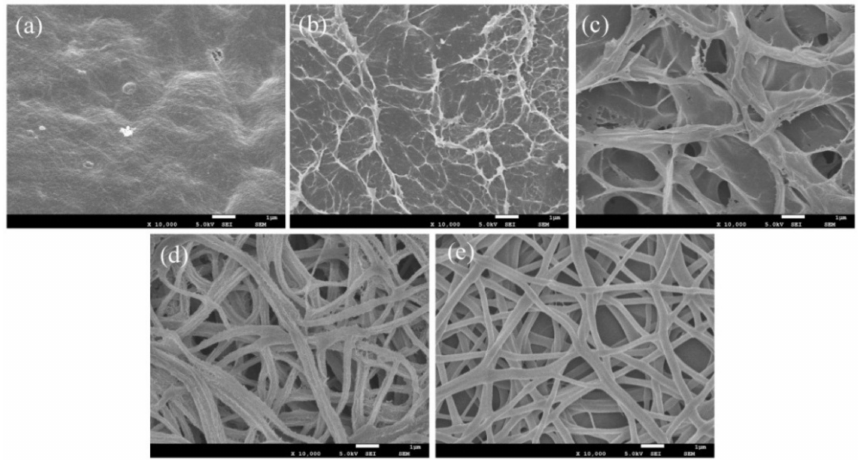
Figure 5. SEM images of electrospun 5CNC/CS/PVA-SH composite nanofibrous films after treatment with solution at ( a ) pH 2, ( b ) pH 4, ( c ) Ph 6, ( d ) pH 8, and ( e ) pH 10 (scale bar: 1 µ